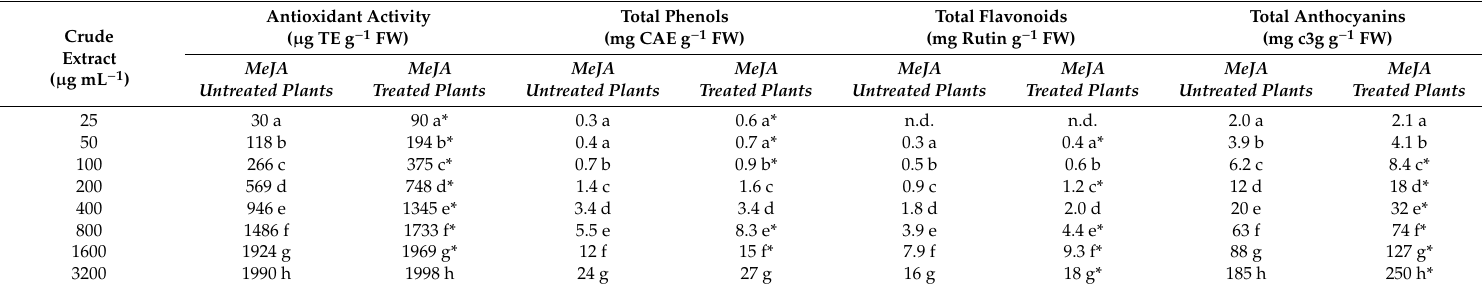
Table 2. Antioxidant properties of leaves aqueous extracts from blueberry plants untreated and treated with MeJA. Crude Extract